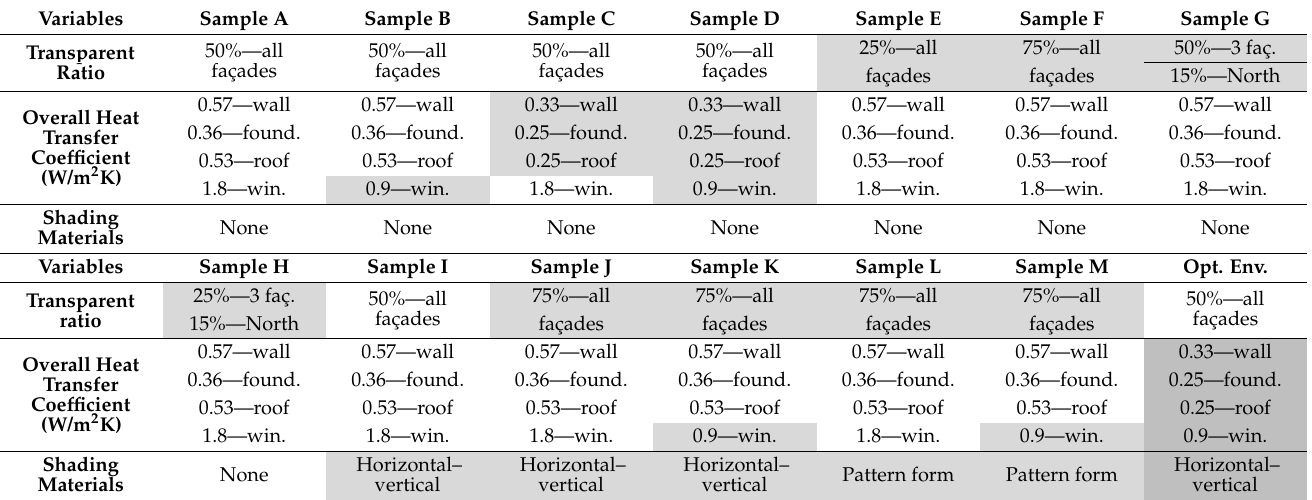
Table 9. The changed properties of scenario types created according to sample A.